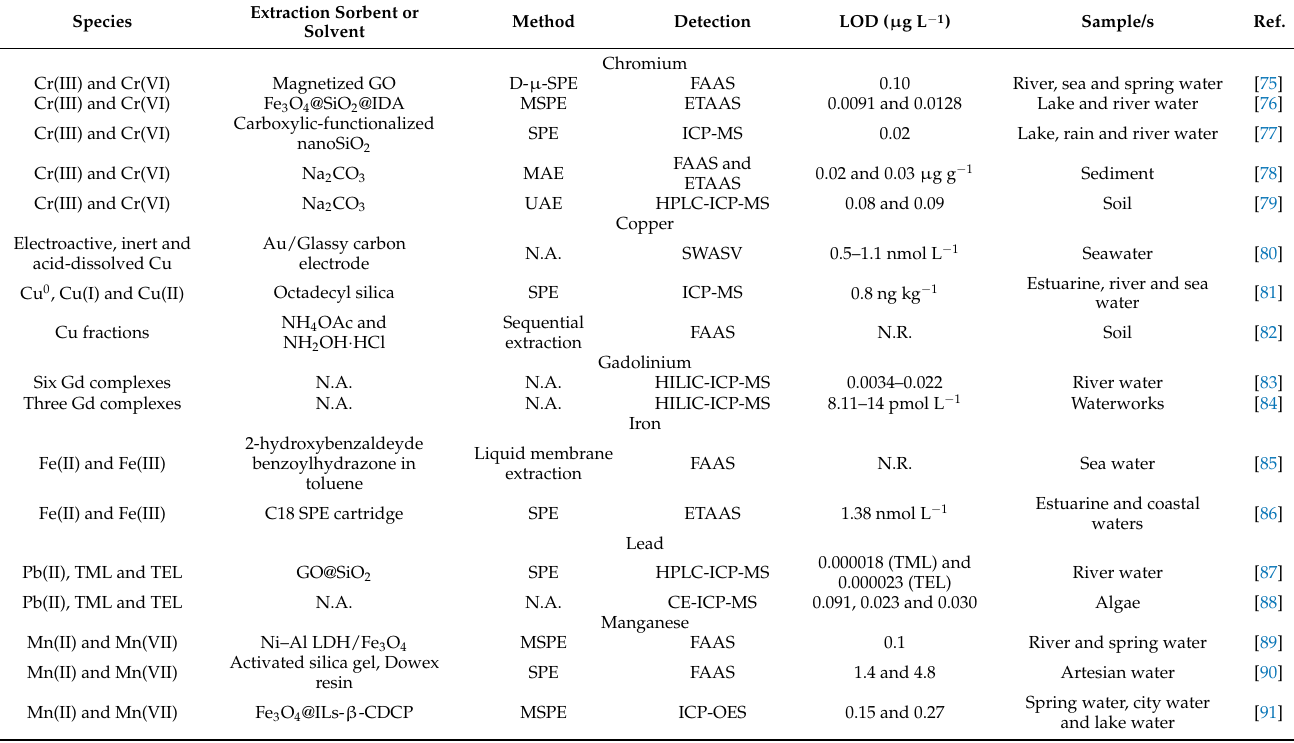
Table 2. Metal speciation analysis reports from 2016